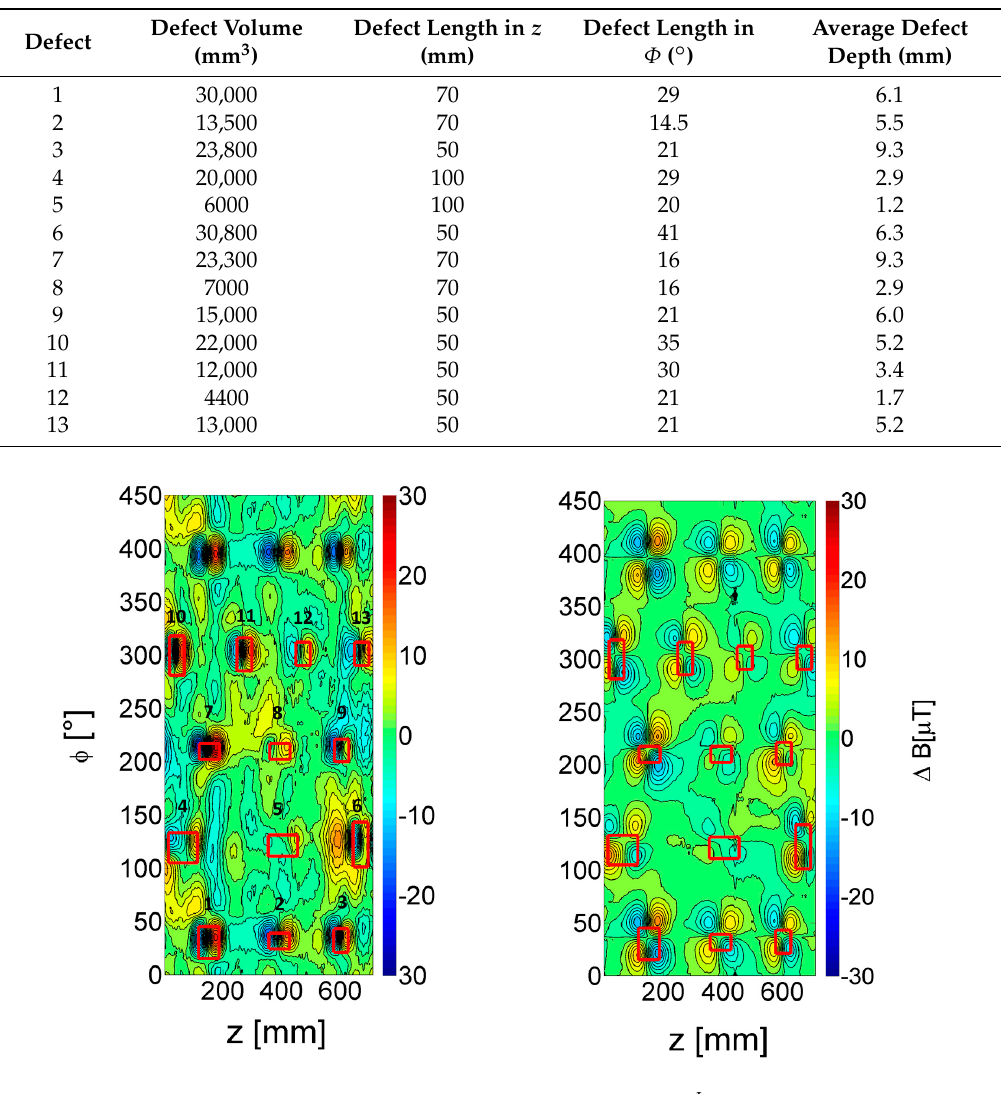
Figure 8. Change in magnetic field amplitude at 20 Hz and 300 A excitation current (r- and Φ -sensors) for pipe with defects described in Table 2.